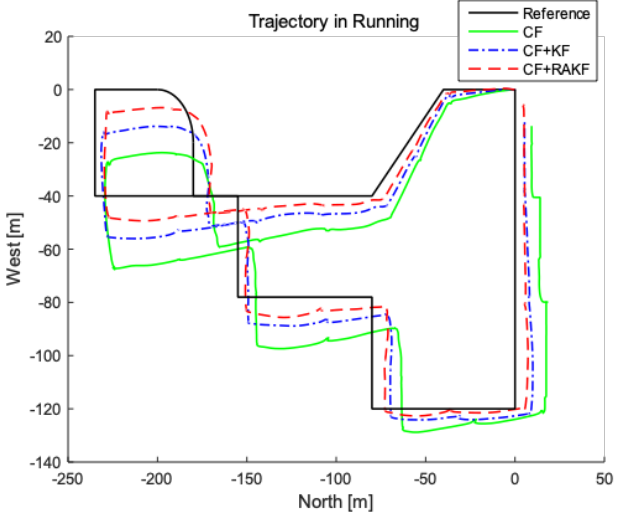
Figure 12. Comparison of trajectory in running under different heading estimation algorithms performed in second floor of IOT Engineering College.